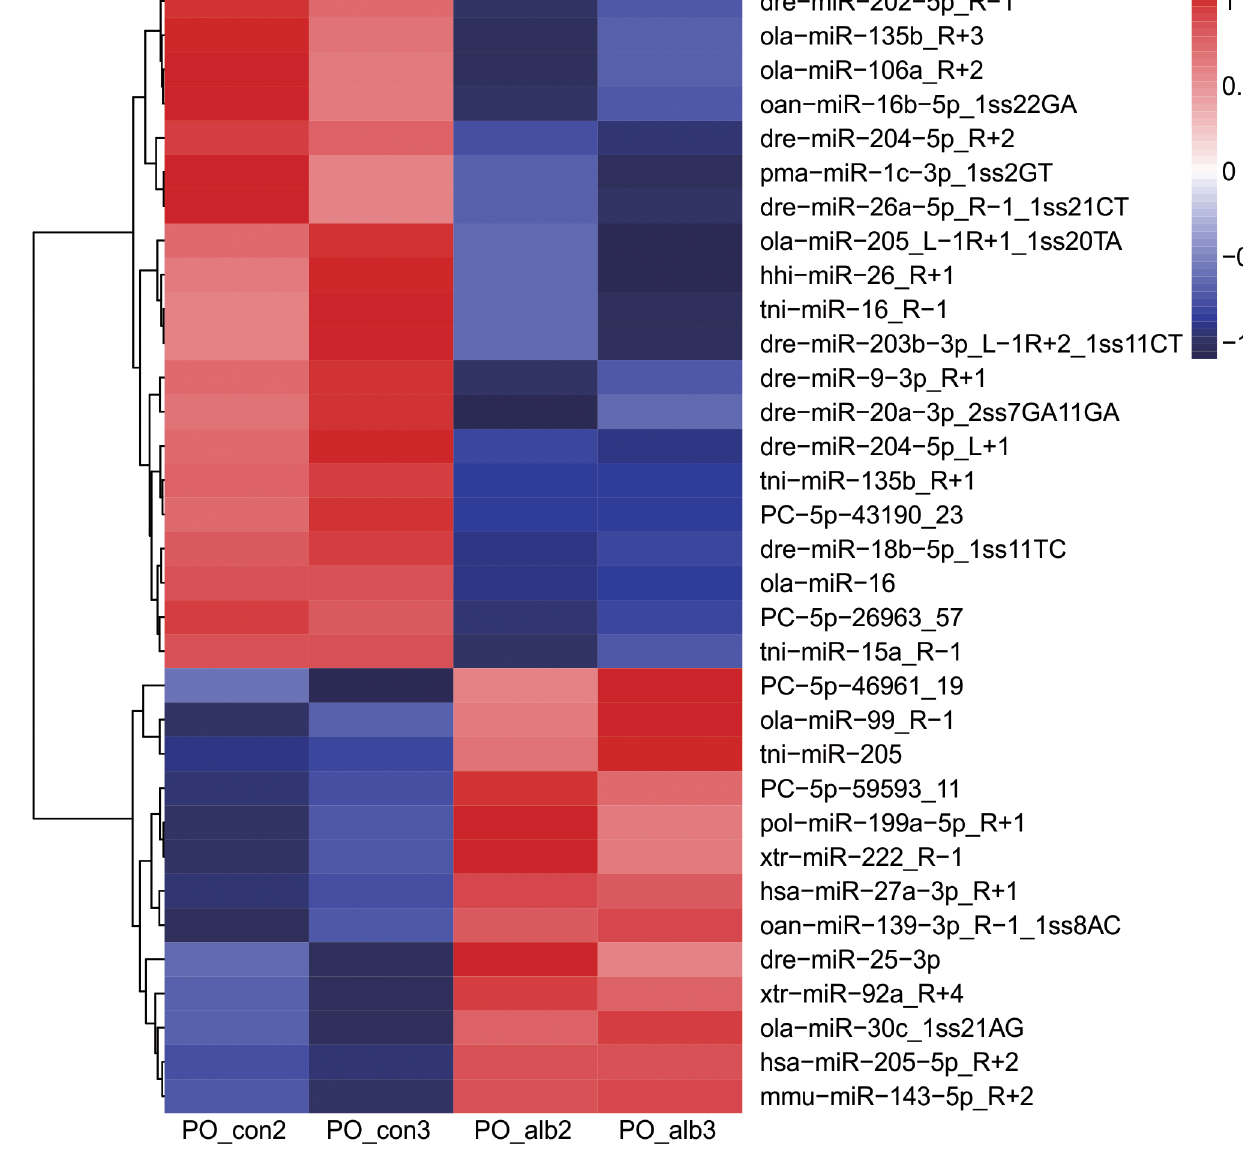
Fig 7. Clustering of expression patterns of 33 differentially expressedmiRNAs. The expressionpatterns of 33 differentiallyexpressed miRNAs (p < 0.05)in the PO_con2, PO_con3, PO_alb2, and PO_alb3librariesare displayedin a pheatmap. Each column represents one library, and the colour bar indicatesrelative expressionlevel from high (red) to low